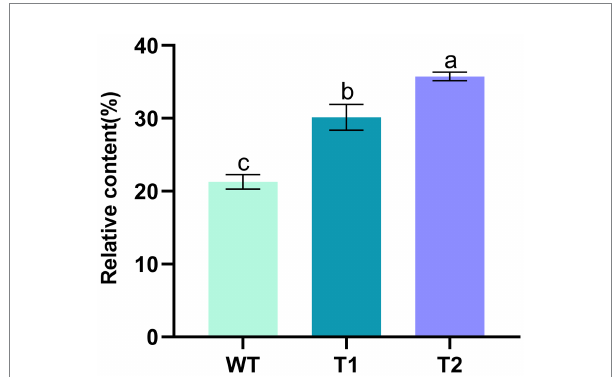
FIGURE 5 Mass percentage of total lipid content in WT and transformants.